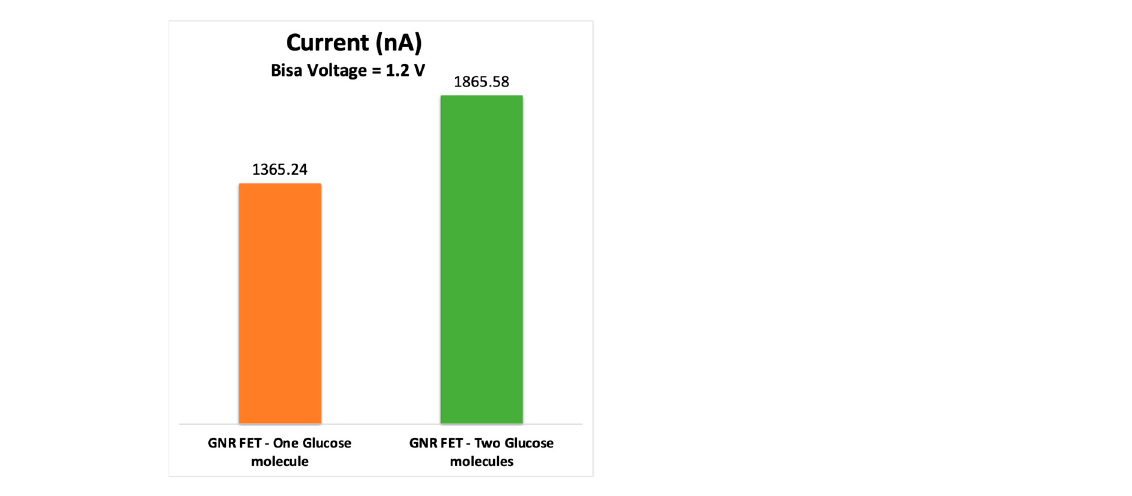
Figure 10. Electrical drain current for the GNR-FET due to one glucose molecule and two glucose molecules.